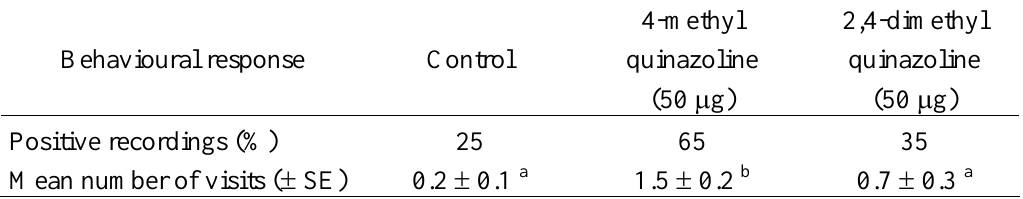
Table 2. Behavioural response of fifth stadium nymphs of T. infestans to 4-methyl quinazoline and 2,4-dimethyl quinazoline in an arena bioassay Behavioural response